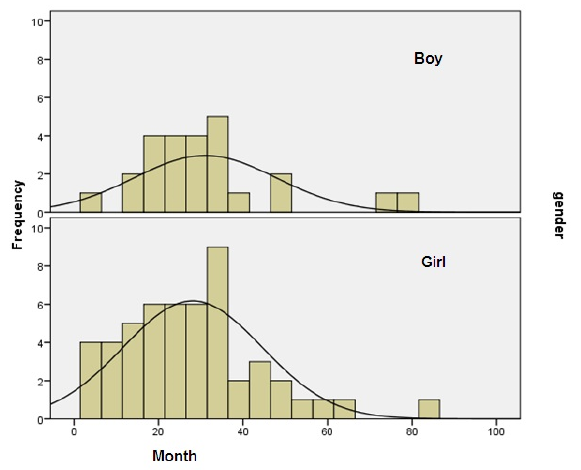
Figure 1. Age range of children based on gender.